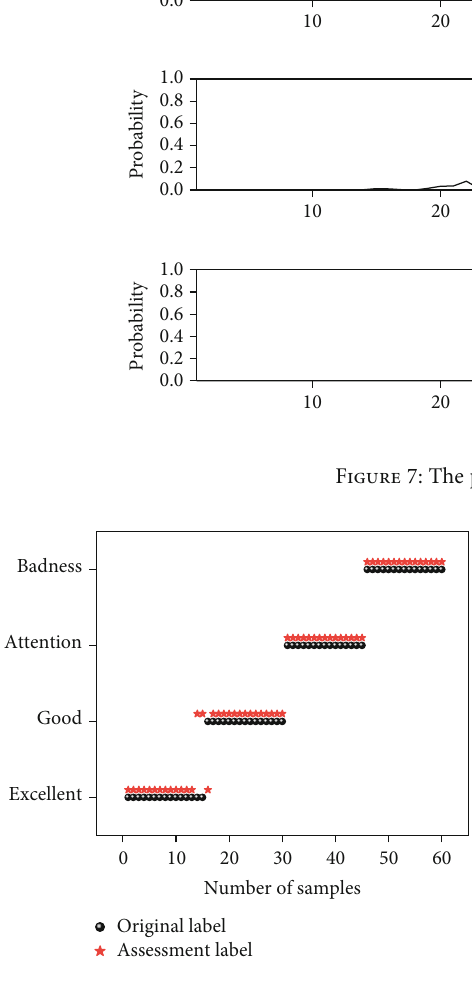
Figure 8: Assessment degree of operating